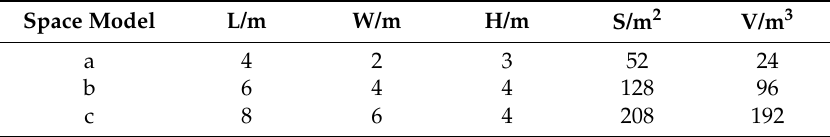
Table 3. The dimensions of closed-space models with different volumes.